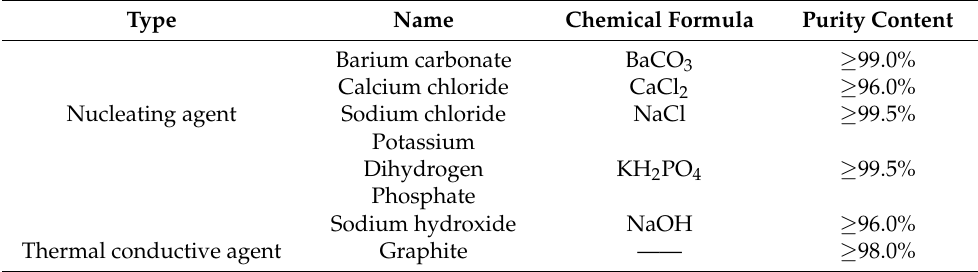
Table 1. Experimental material